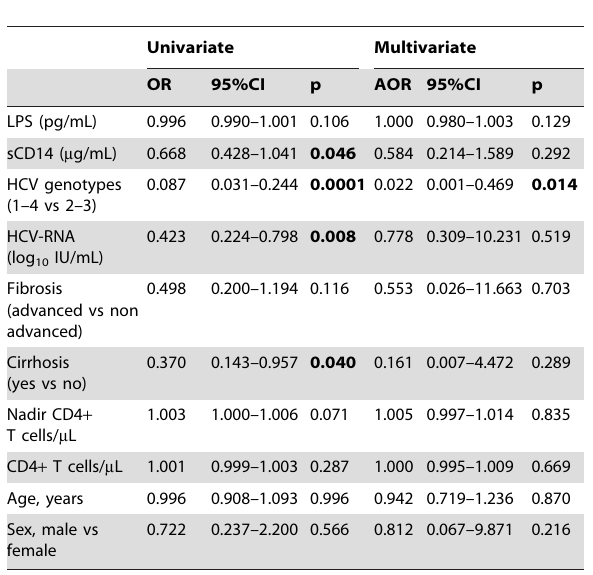
LEGEND. LPS, soluble CD14, CD4 + T cells/ m L, age, HCV-RNA log 10 cp/mL for each unit more. sCD14 and LPS were measured in plasma samples; sCD14 m g/ mL, LPS pg/mL. Multivariate analysis was performed in 65/98 patients for whom all the clinical, epidemiological and biological parameters under study were available. OR, odds ratio; AOR, adjusted odds ratio; CI, confidence interval. p . 0.05 was considered non significant.